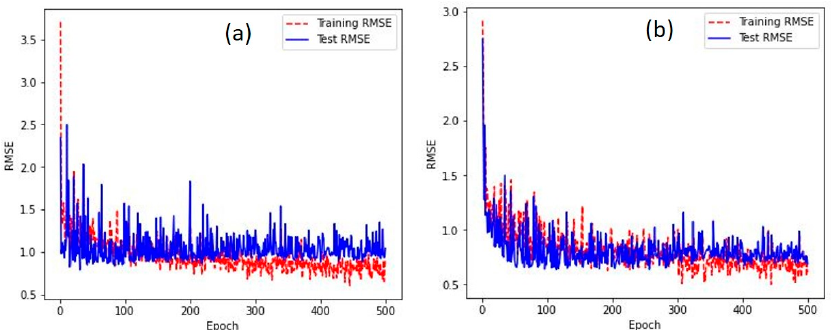
Figure A4. Changes in training and test root mean squared error (RMSE) of the DNN regressors for the barley ( a ) and wheat ( b ) datasets. Table A1. Observed versus simulated leaf area index (LAI) values of barley and wheat for the different treatments in terms of the mean absolute error (MAE), the root mean squared deviation (RMSD), and Nash–Sutcliffe model efficiency (ME). Crop LAI (mean ± 1 SD) Treatment MAE RMSD ME Simulated Observed ——— m − 2 ——— —— m − 2 —— unitless Wheat